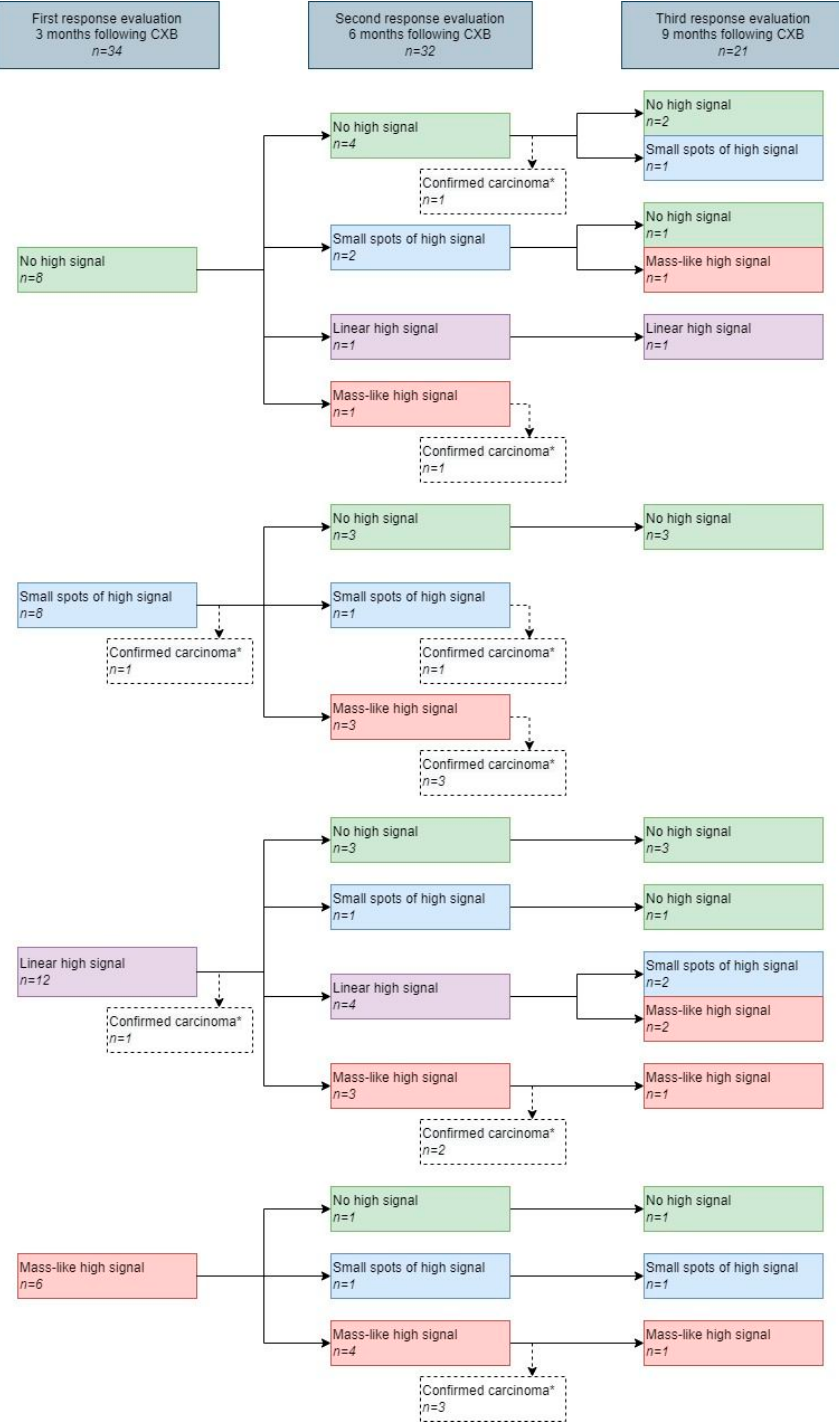
Figure 6. The morphology of the diffusion signal during follow ‐ up. * No further follow ‐ up on en ‐ doscopy and MRI of patients with histopathological confirmation of carcinoma obtained by biopsy or